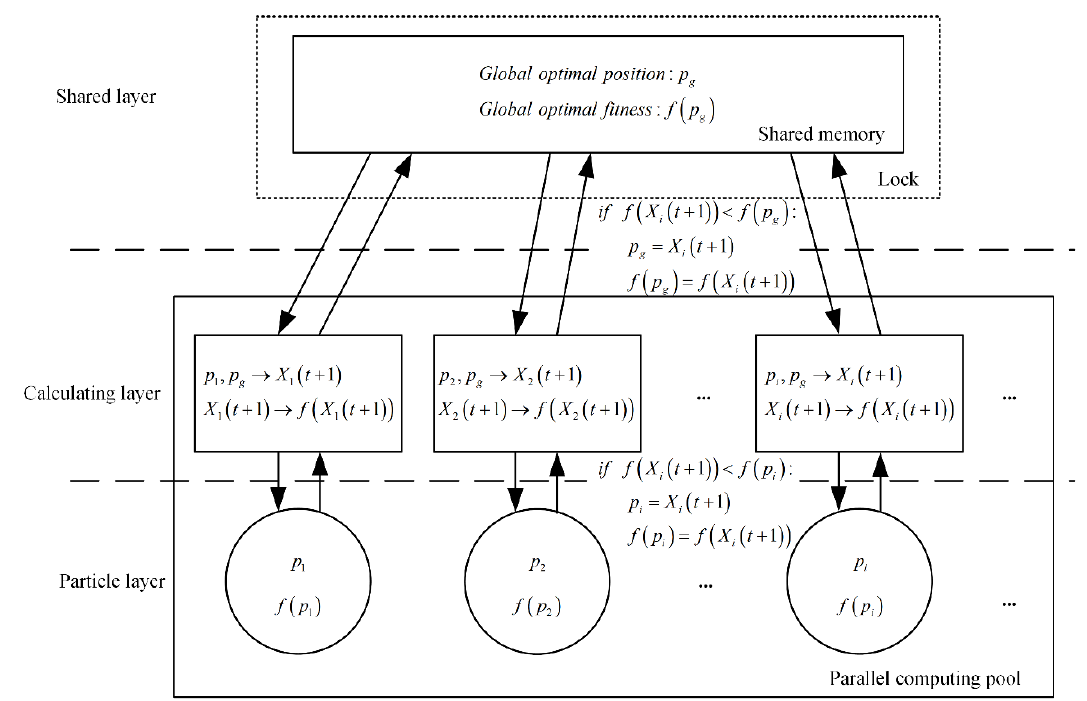
Figure 5. Architecture of parallel computing.